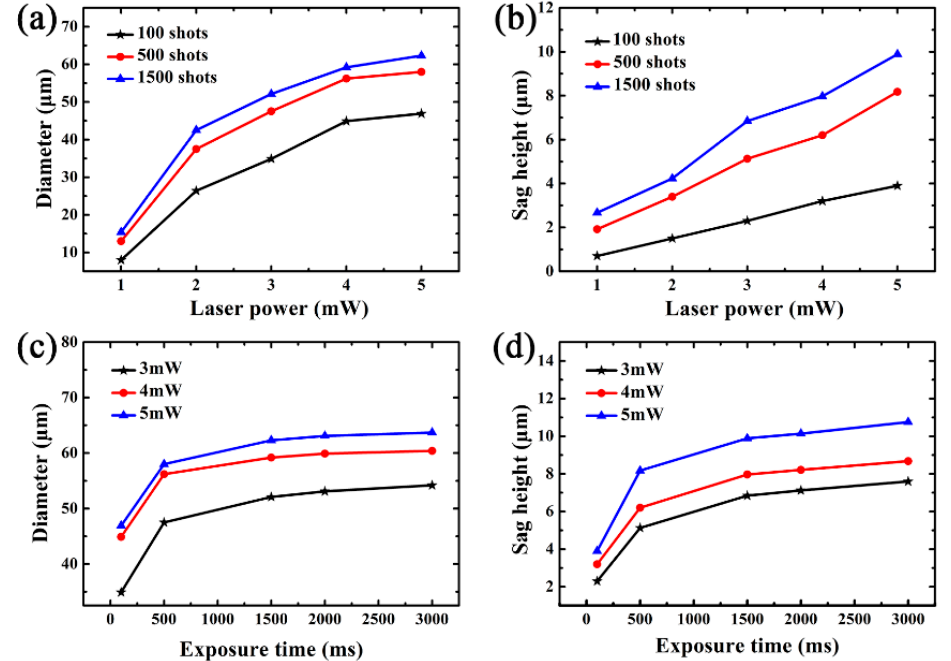
Figure 6. ( a ) The power dependency of the diameter of the concave structures. ( b ) The power dependency of the sag height of the concave structures. ( c ) The relationship between the diameter and laser exposure time. ( d ) The relationship between the sag height and the laser exposure time.